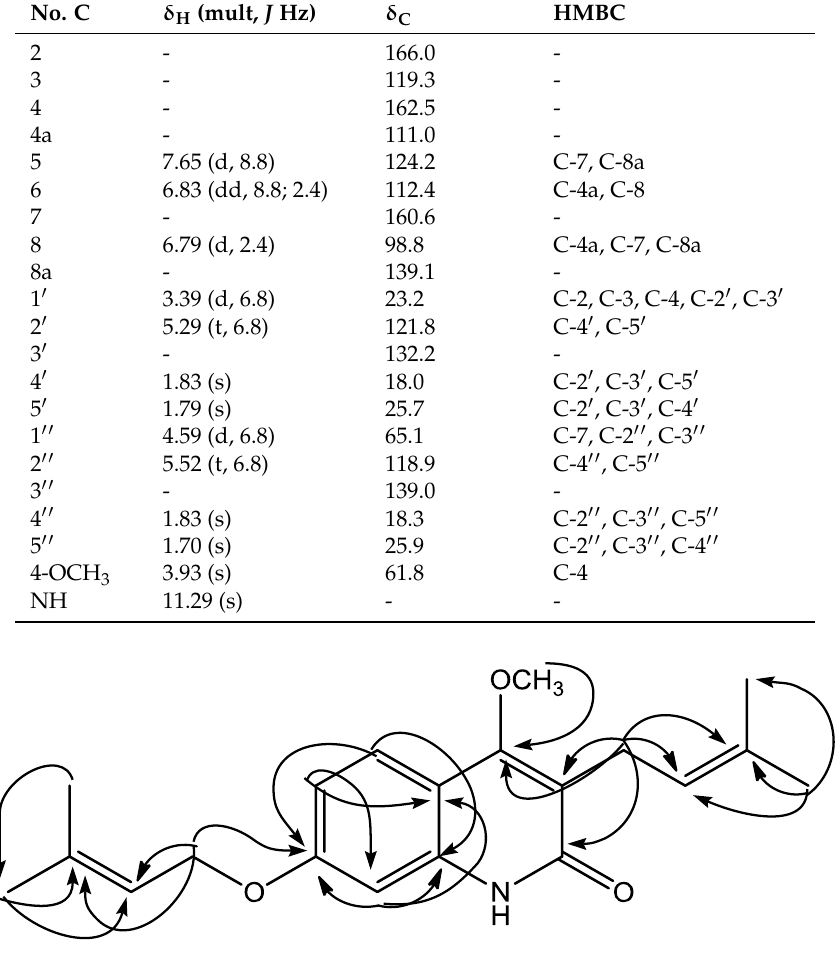
Figure 2. Selected HMBC correlations for 1 . Table 2. Cytotoxic analysis against P-388 cells and antiplasmodial activity of compound 1 .